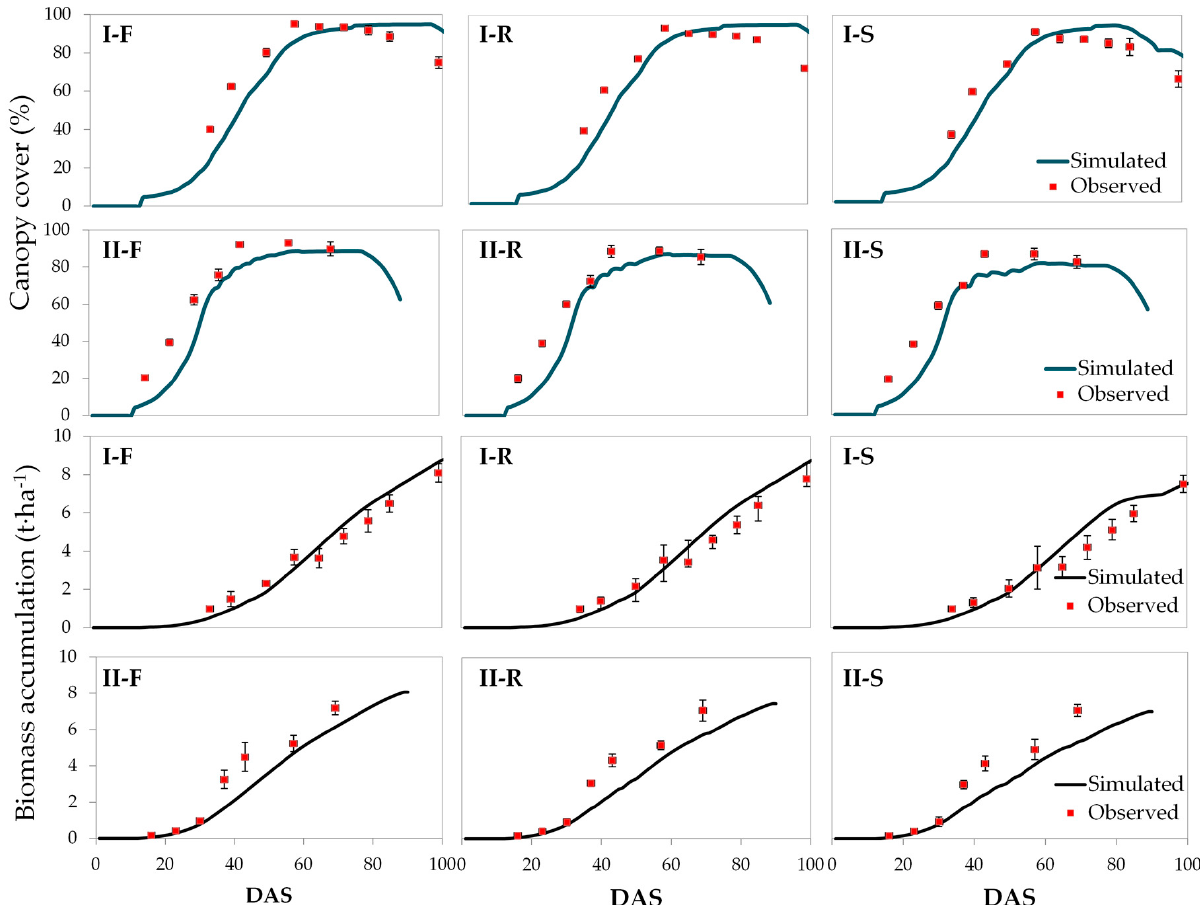
Figure 1. Simulation of canopy cover and biomass accumulation throughout the growing cycle of common bean used for model calibration per irrigation treatment; full (F) and deficit (R and S) irrigation treatments and sowing periods I (spring) and II (late spring).